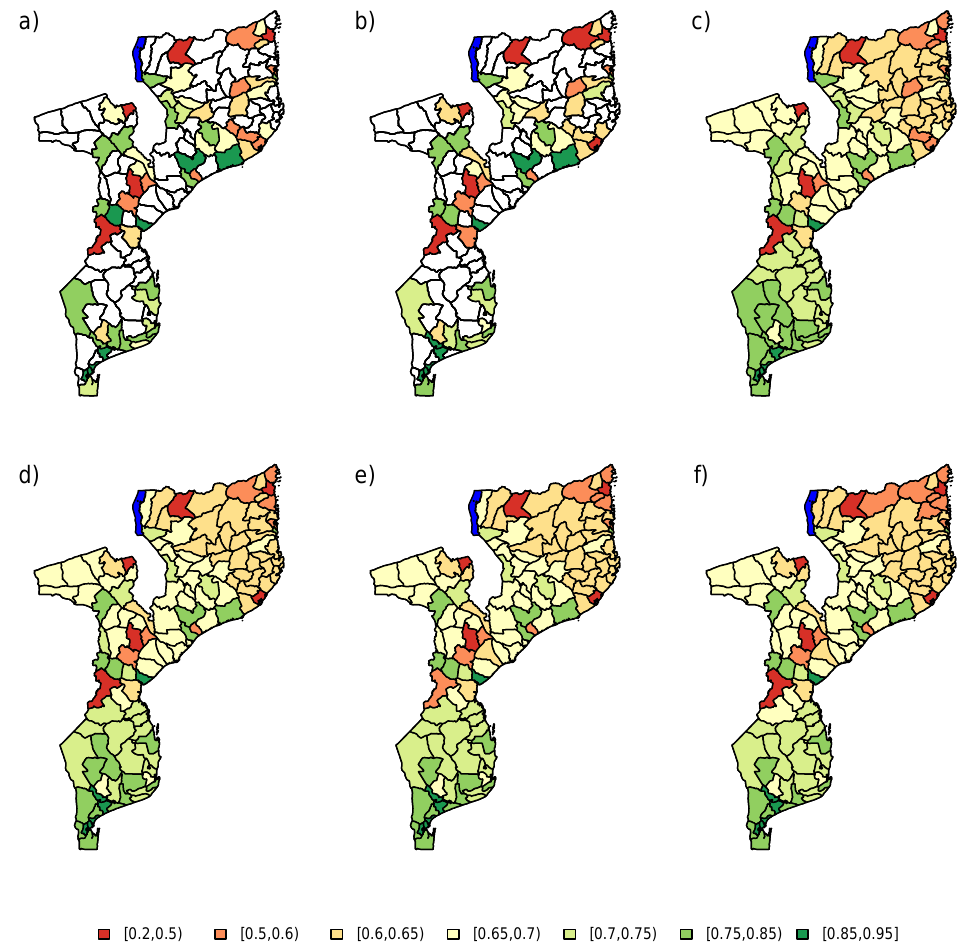
Figure 9. Maps for estimated school attendance proportions in 2008 PSIA study for ( a ) UNW, ( b ) HT, ( c ) NB, ( d ) LN, ( e ) AS, and ( f ) ES estimators. No auxiliary data was used in the modeling process. UNW = unweighted estimator; HT = Horvitz–Thompson estimator; NB = naive binomial model; LN = logit-normal model; AS = arcsine model; ES = effective sample size